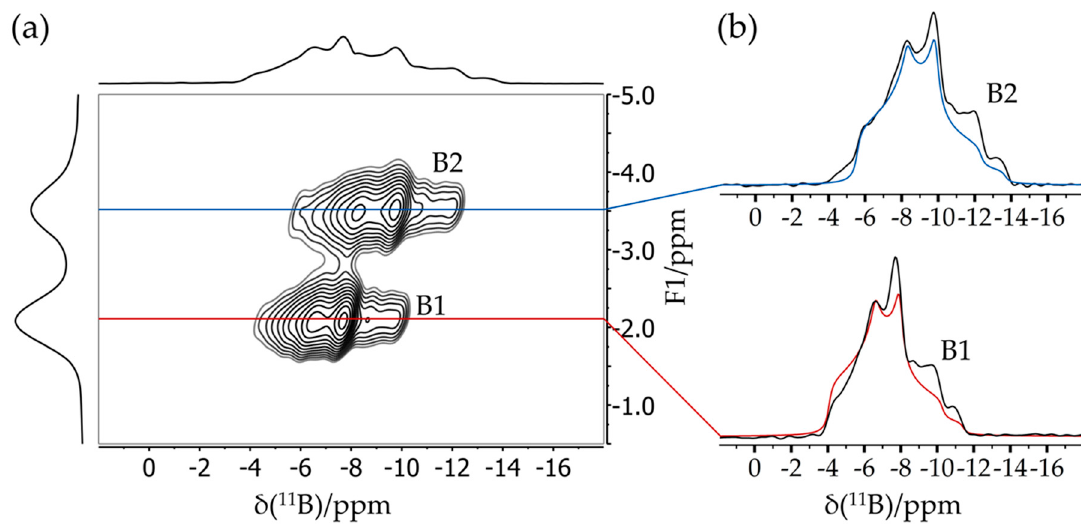
Figure 6. (a) Typical TQ MAS spectrum of an FLP octamer featuring two distinct boron sites B1 and B2. While the spectrum in the horizontal dimension is equivalent to the regular MAS spectrum, the spectrum in the vertical (F1) dimension is purely isotropic, yielding well-separated symmetric line shapes. ( b ) Corresponding F2 sections representing resolved MAS spectra of the individual boron sites including line shape simulations (see Section 3.6).